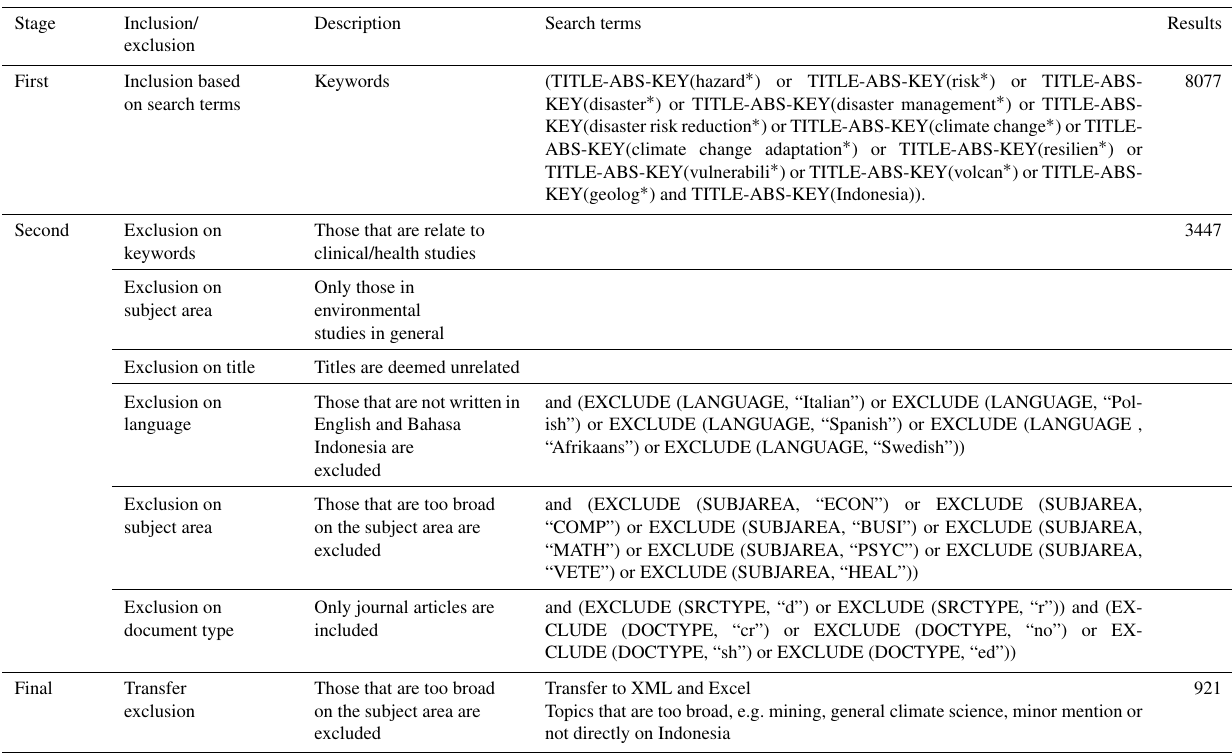
Table 1. Multi-stage processes for inclusion and exclusions for search terms.